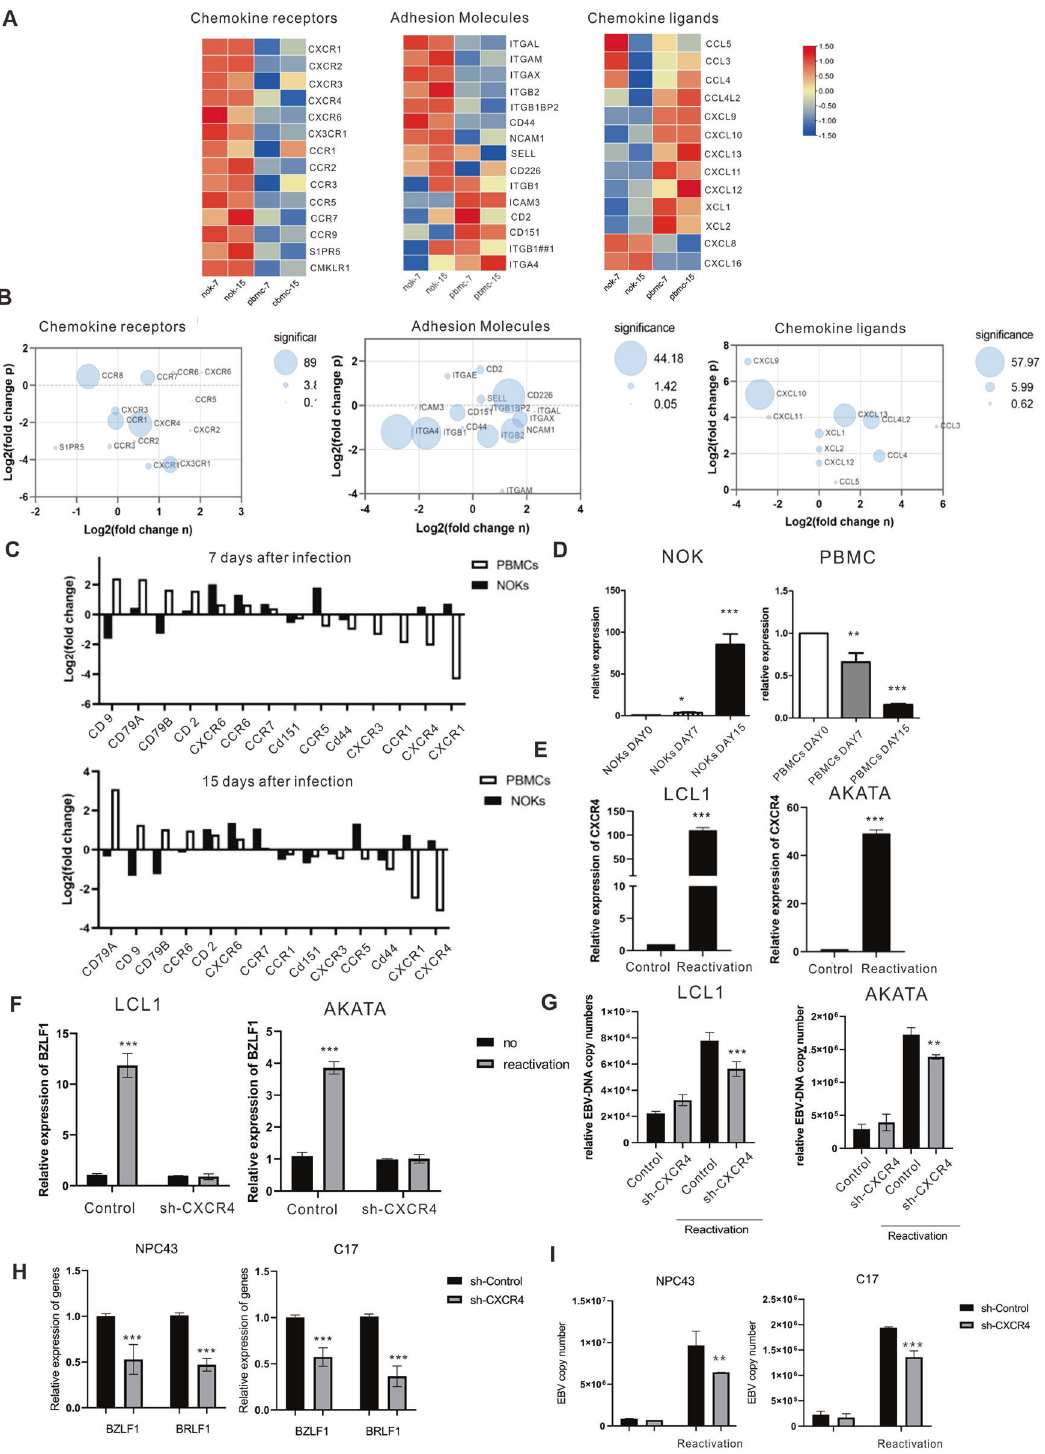
Fig. 7 Differential gene expression of chemotactic and adhesion molecules. Differential gene expression of chemotactic and adhesion molecules showing that CXCR4 plays a critical role in virus reactivation. A Heat maps that report log2 values for the genes of chemokine related. B Bubble plots that display genes that are graphed A . C Surface expression phenotype on expanded EBV infected NOKs and PBMCs, compared to mock infected cells. D Validation of CXCR4 expression by qRT-PCR. E CXCR4 expression in reactivation of LCL1 and AKATA cells with qRT-PCR. The expression of CXCR4 increased from latent to reactivation phase. F Quanti fi cation of BZLF1 mRNA before and after the reactivation with TPA and Butyrate from three replicate experiments is shown. G EBV DNA copy number was detected by quantitative PCR in LCL1-shCXCR4 cell lines, LCL1-shControl, AKATA-shCXCR4 and AKATA-shControl cell groups before and after reactivation. H Quanti fi cation of EBV lytic gene BZLF1 and BRLF1 mRNA from three experiments is shown in NPC43-shCXCR4 cells and C17-shCXCR4 cells. I EBV DNA copy number was detected by qPCR in sh-CXCR4 and control groups before and after reactivation with TPA and Butyrate in NPC43 and C17 cells.